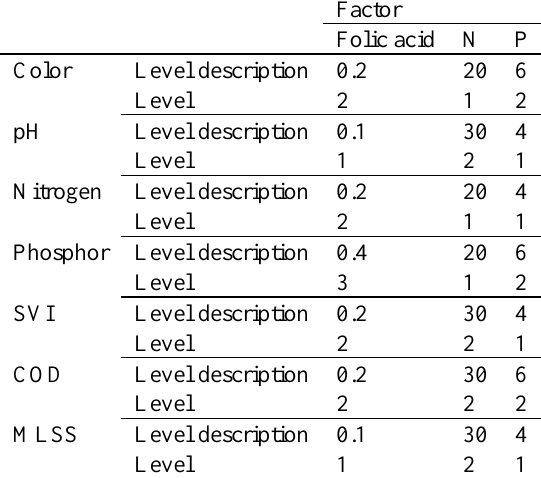
Table 6. Optimum condition for removal of traits